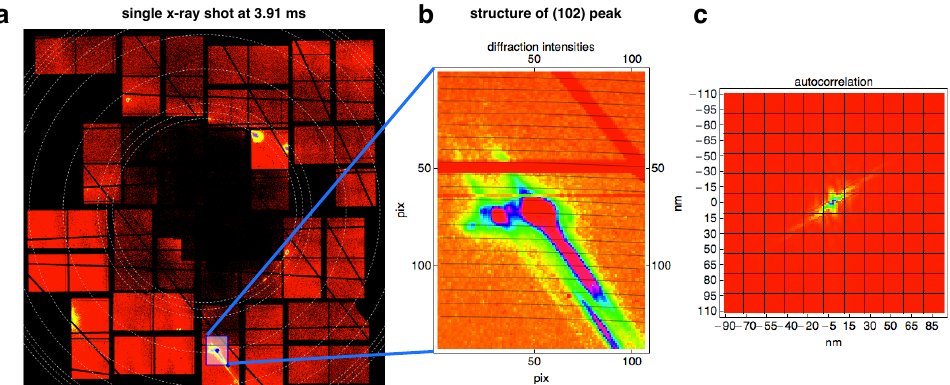
Figure A15. ( a ) Single-shot coherent diffraction pattern of a strong hit at 3.91 ms travel time. The dashed white lines show the expected locations of the Bragg peaks for hexagonal ice I h [51]. ( b ) A zoom-in on the (102) peak in reciprocal space showing several maxima. ( c ) 2D Fourier transform of the diffracted intensities showing the resulting autocorrelation in real space.